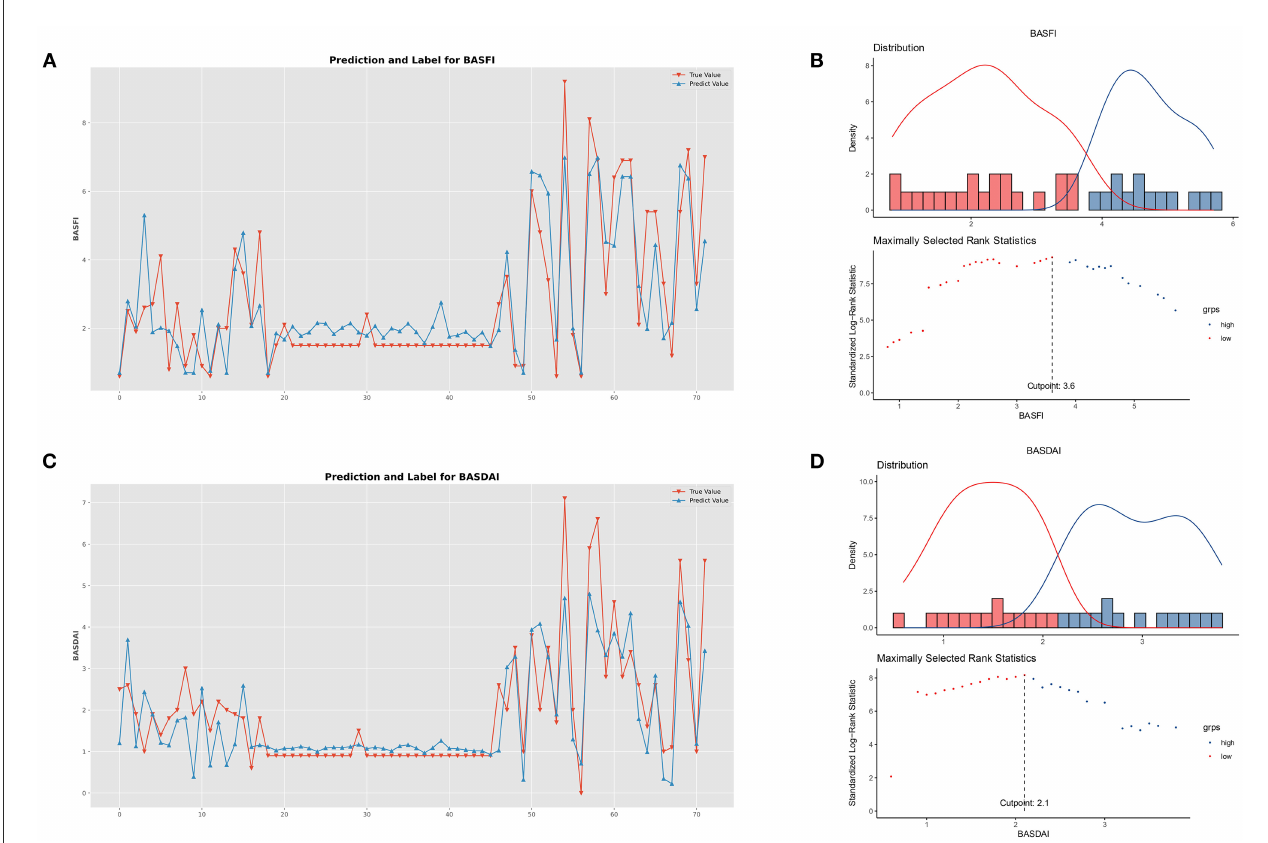
FIGURE6 Performance of clinical prediction models and optimal cut-off value for BASFI and BASDAI. (A) Predicted value and the true value of BASFI. (B) Distribution and an optimal cut-off value of BASFI. (C) Predicted value and the true value of BASDAI. (D) Distribution and an optimal cut-off value of